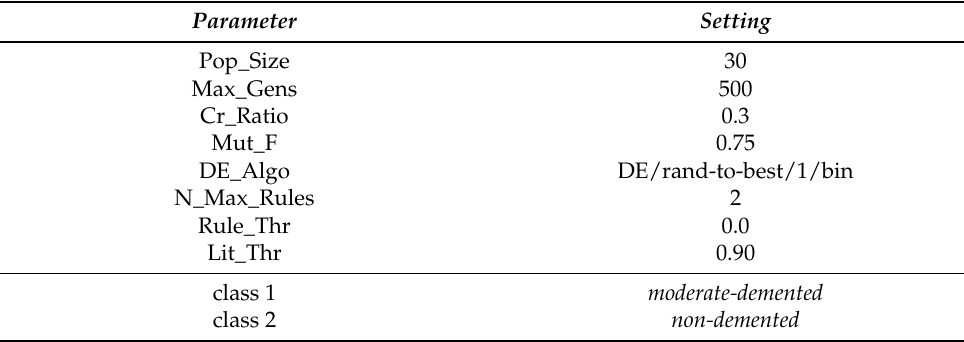
Table 2. The Parameter Setting for DEREx for the 2-Class